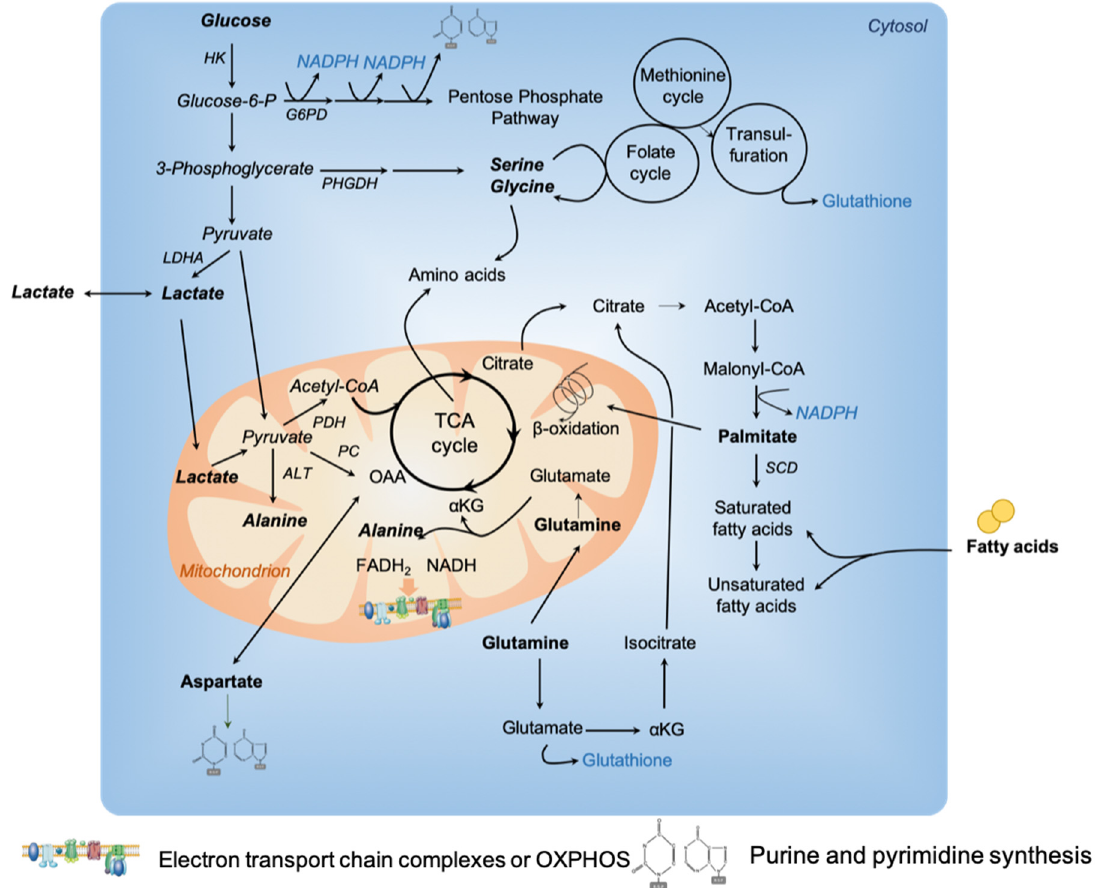
Figure 1. Carbon-source preferences and use in cancer metabolism. Glucose carbons are oxidized to produce pyruvate trough glycolysis. Glucose carbons fuel the tricarboxylic acid (TCA) cycle and subsequent oxidative phosphorylation (OXPHOS) in mitochondria. Intermediates of glucose metabolism are diverted from glycolysis and used for biosynthetic purposes such as the pentose phosphate pathway, the serine pathway, and the one carbon metabolism–Folate–Methionine cycle and the transulfuration pathway. The TCA cycle can be fueled through anaplerotic reactions involving glutamine, alanine, aspartate, serine, palmitate (or other fatty acids, not represented) and lactate. Carbon sources are highlighted in bold, anti-oxidant in blue and enzymes in italic. α KG: alpha-ketoglutarate; ALT: Alanine aminotransferase; CoA: Coenzyme A; FAD: flavin adenine dinucleotide; G6PD: Glucose-6-phosphate dehydrogenase; HK: Hexokinase; LDHA: Lactate dehydrogenase A; NADPH: Nicotinamide adenine dinucleotide phosphate; OAO: Oxaloacetate; PC: Pyruvate Carboxylase; PDH: Pyruvate dehydrogenase; PHGDH: Phosphoglycerate dehydrogenase; SCD: stearoyl-CoA desaturase.